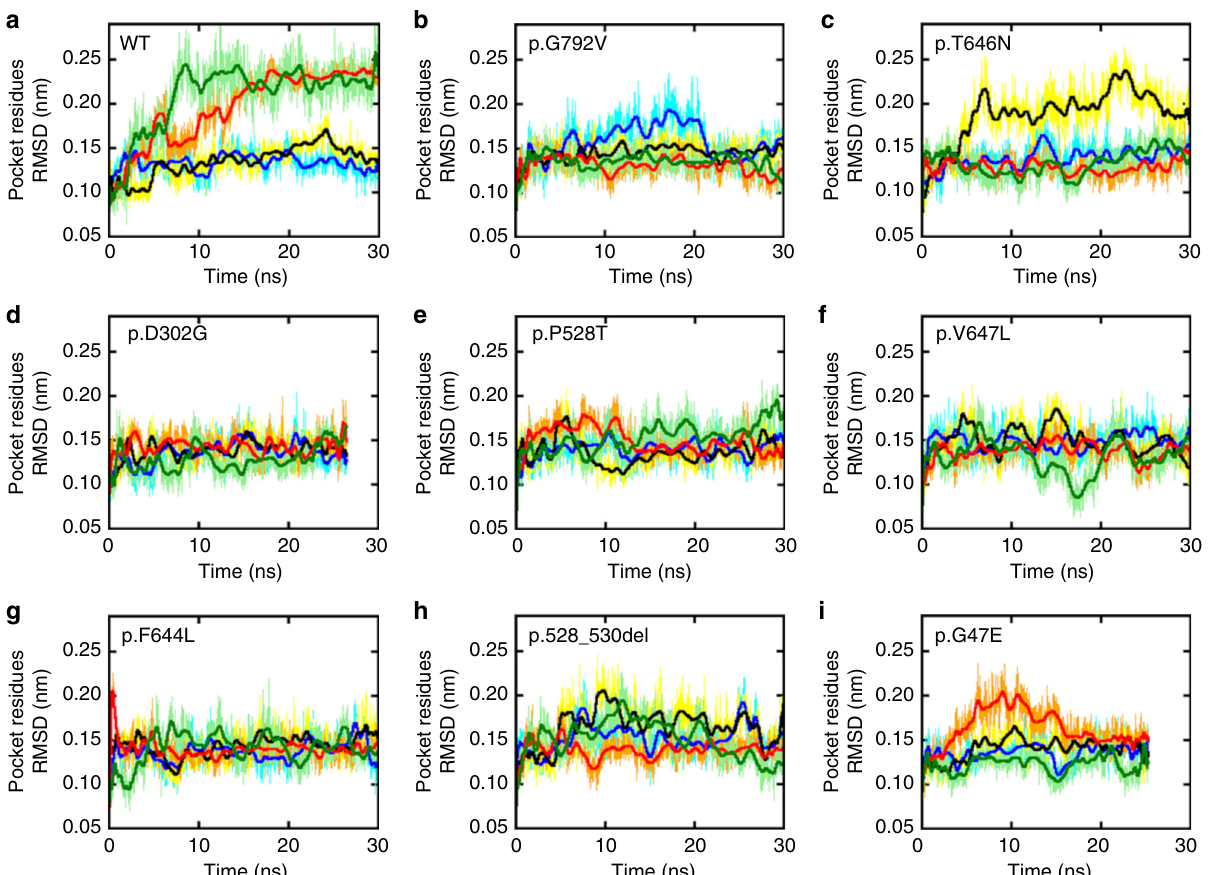
Fig. 4 GluA2 Molecular dynamic stimulations predict reduced mobility at the agonist binding site. Root Mean Square Deviation (RMSD) of the GluA2 Glutamate binding pocket (GLU) amino acids along the simulated time for the wild-type protein (top left) and GRIA2 mutants ( a – i ). In all panels the color code is: chain A (blue/cyan), chain B (black/yellow), chain C (red/orange), and chain D (light/dark green). Thicker lines indicate running averages over 100